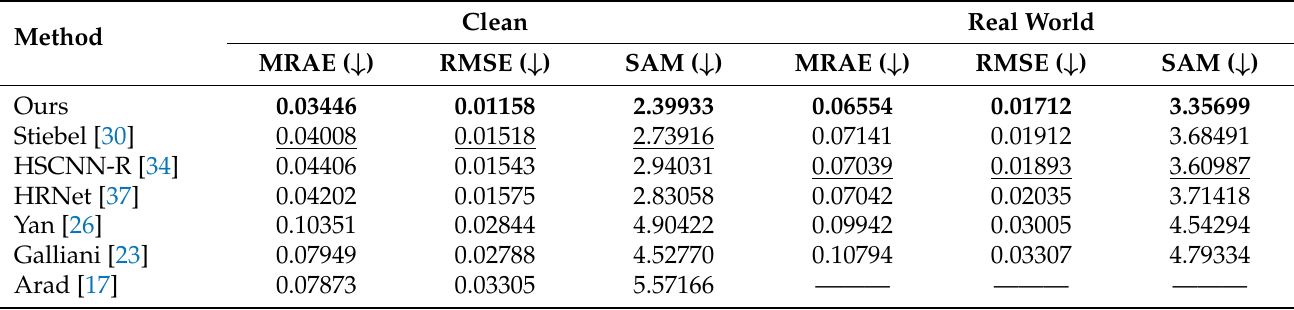
Figure 6. Visual comparison of the five selected bands on “ARAD_HS_0451” image from the final testing set of NTIRE2020 “Real World” track. The best view on the screen. Table 3. The quantitative results of final test set of NTIRE2020 “Clean” and “Real World” tracks. The best and second best results are bold and